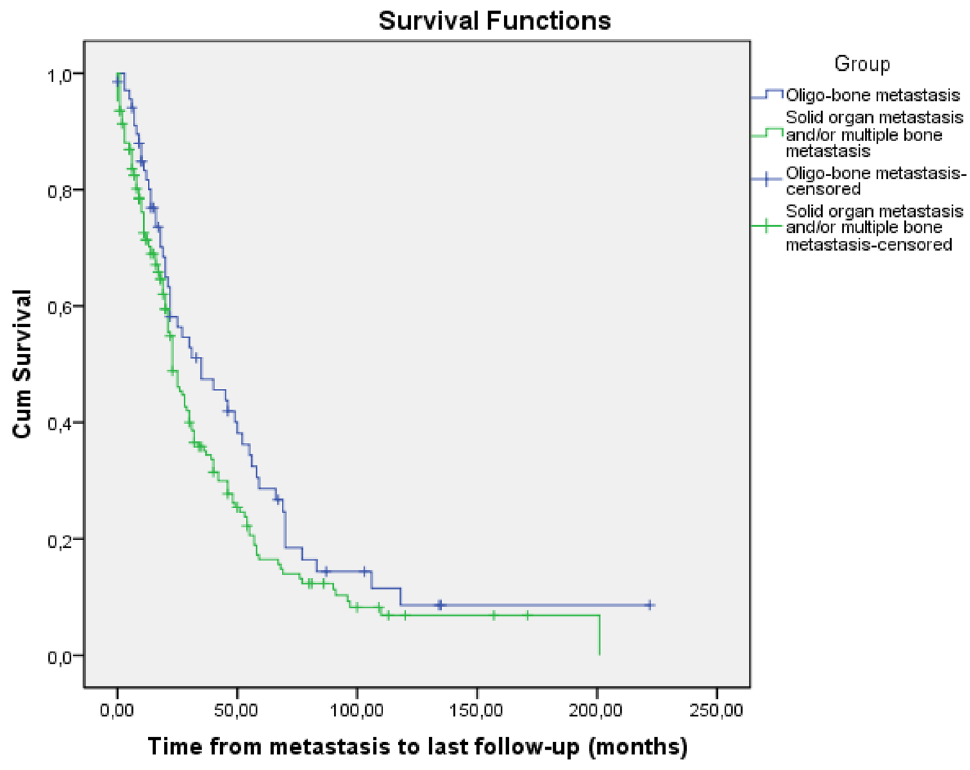
Figure 5. Overall survival of patients with OMBD and multimetastatic disease after the occurrence of metastasis. (OMBD: 54.4 ± 8.2 months, widespread metastatic disease: 41.3 ± 4.3 months; p =